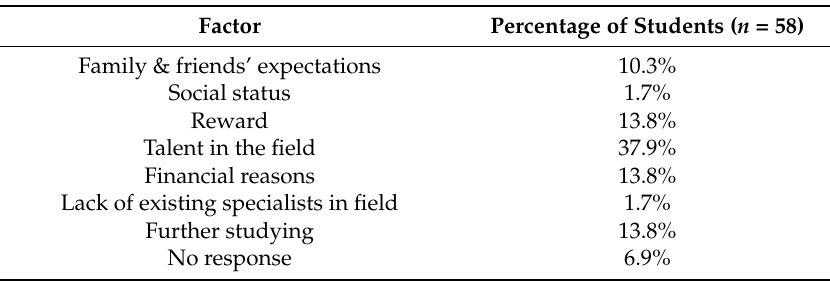
Table 5. Factors influencing decision to specialize.